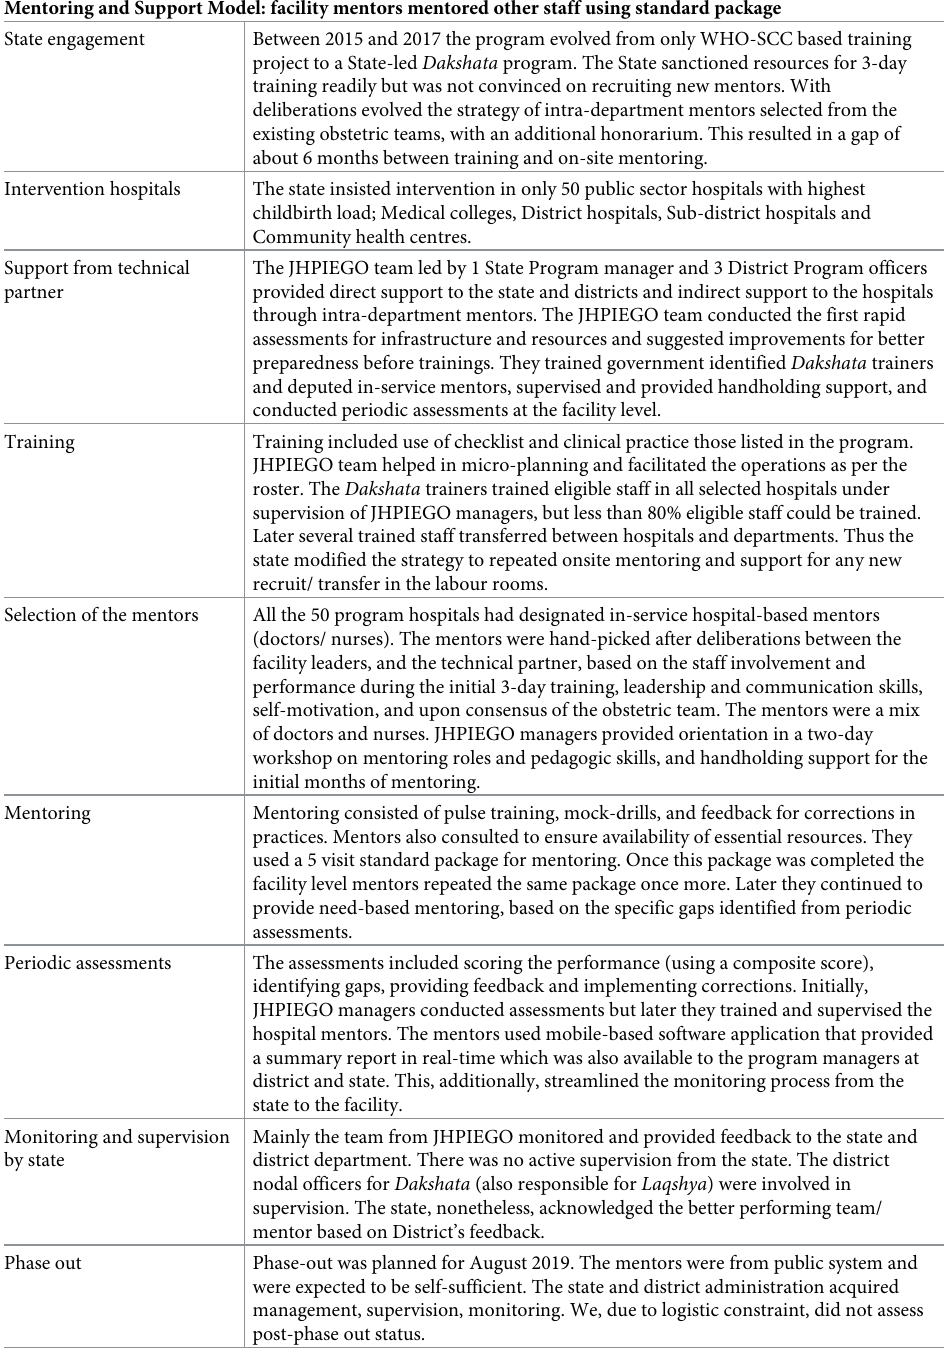
Table 1. Summary description of intervention in Andhra Pradesh as on January